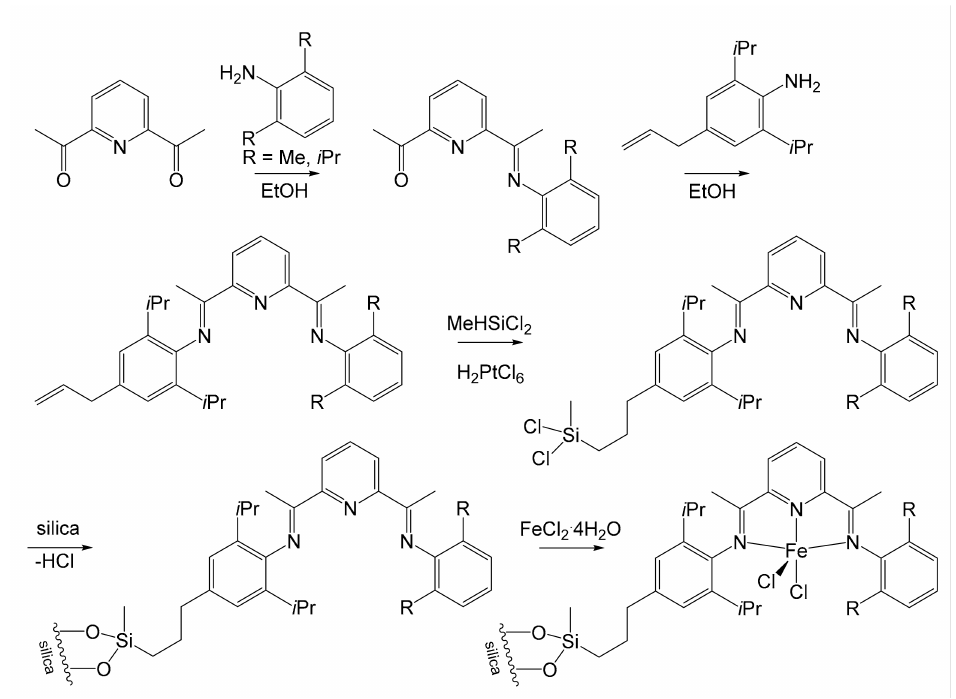
Figure 5. Li’s immobilization strategy over silica for iron pre-catalyst [51]. Simultaneous to the attempts of immobilization on silica, a new path was explored by Jin and Liu, who managed to immobilize the iron complex by co-polymerization with polystyrene (PS) on silica spheres [52]. The pre-catalyst was synthesized by employing already functionalized anilines, in a manner similar to what Li had previously